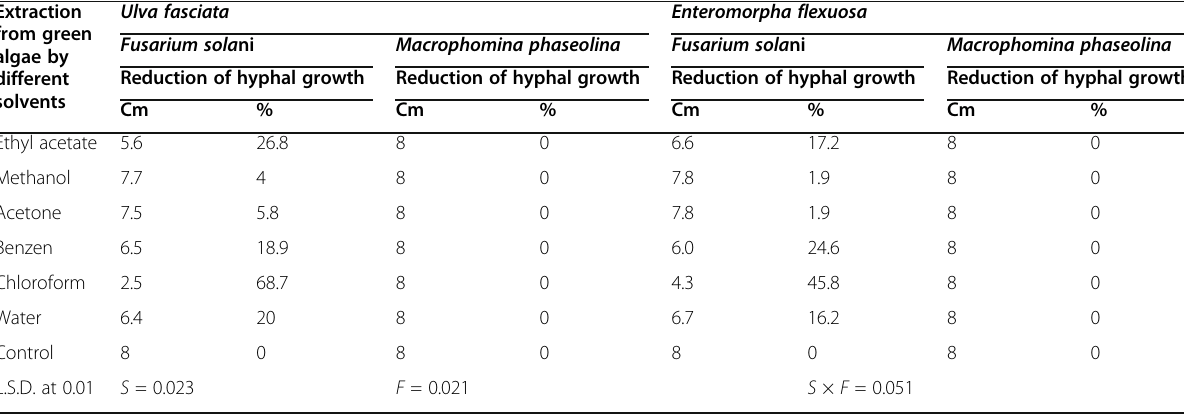
Table 1 Effect of Ulva fasciata and Enteromorpha flexuosa extracts by using different solvents on the mycelial fungal growth reduction of Fusarium solani and Macrophomina phaseolina of cucumber on PDA medium Extraction from green